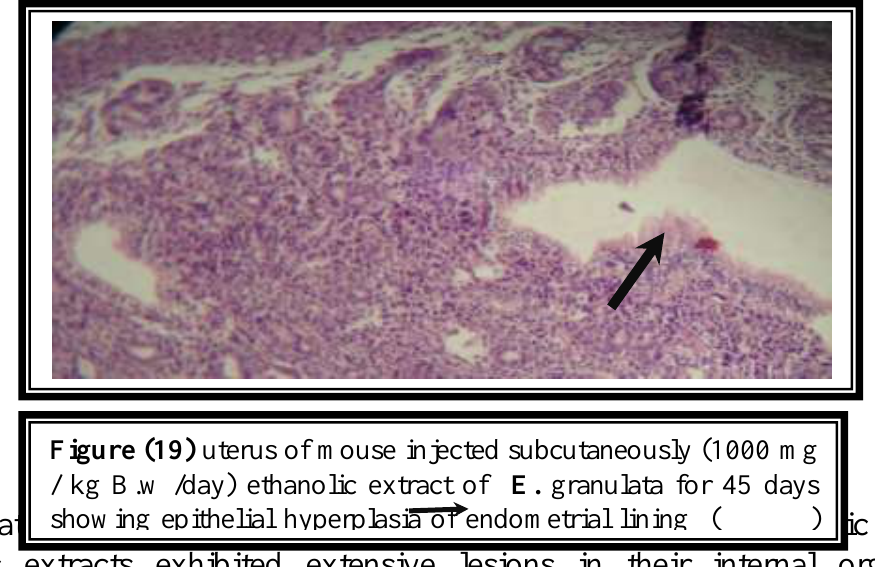
Figure (19) uterus of mouse injected subcutaneously (1000 mg / kg B.w /day) ethanolic extract of E. granulata for 45 days showing epithelial hyperplasia of endometrial lining ( )